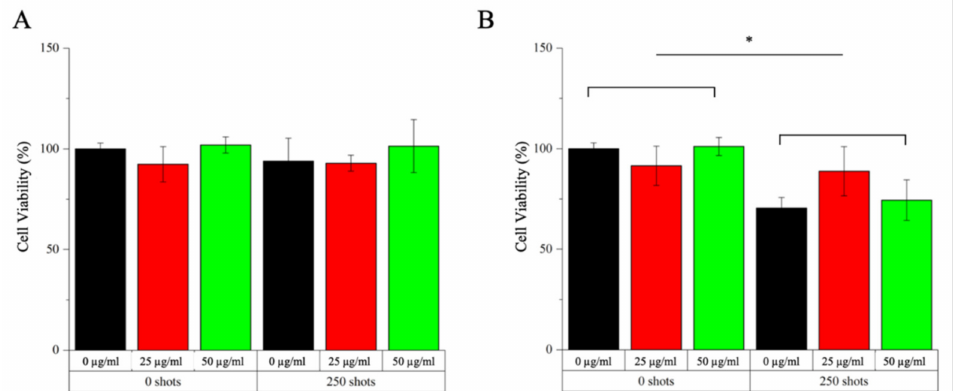
Figure 6. Study of INTERNAL effects with a-TiO 2 -NH 2 /BSA NPs on Daudi cell line in combination with single ( A ) and multiple ( B ) SW treatments (3 times/day). In each graph are depicted the conditions of cells in absence (0 shots) or treated with shock waves (250 shots). Different samples are prepared per assay: control untreated cells (0 µ g/mL, black bars), cells incubated with 25 µ g/mL a- TiO 2 -NH 2 /BSA NPs for 24 h (25 µ g/mL, red bars), cells incubated with 50 µ g/mL a-TiO 2 -NH 2 /BSA NPs for 24 h (50 µ g/mL, green bars). Cell viability is recorded 24 h after the SW treatment with the WST-1 proliferation reagent. Data are reported as the cell viability with respect to the control referred as the 100%. Bars represent mean percentages of cell viability with respect to the control cells ± SEMs, n ≥ 2. 2-way ANOVA was performed to determine statistical significance (* p <